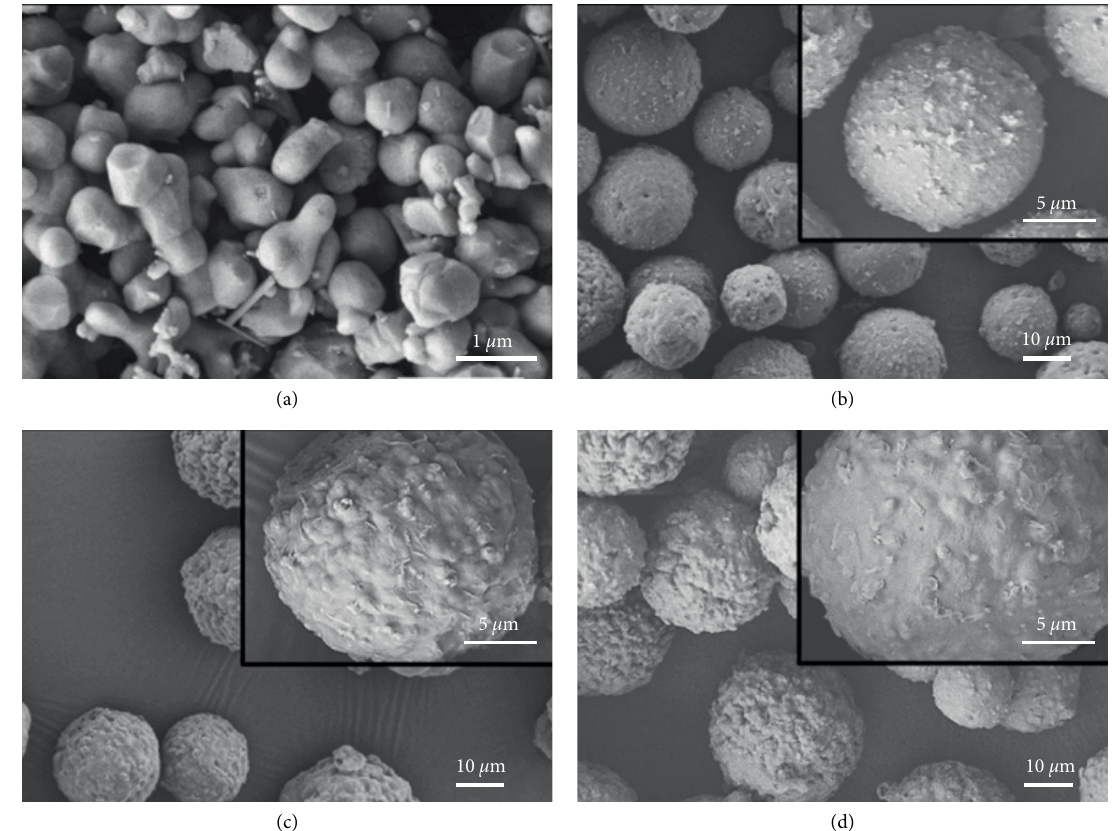
Figure 1: SEM images showing the TCP and INH-loaded gelation microparticles of (a) TCP, (b) INH@GMs, (c) INH-TCP@GMs3367 and (d)